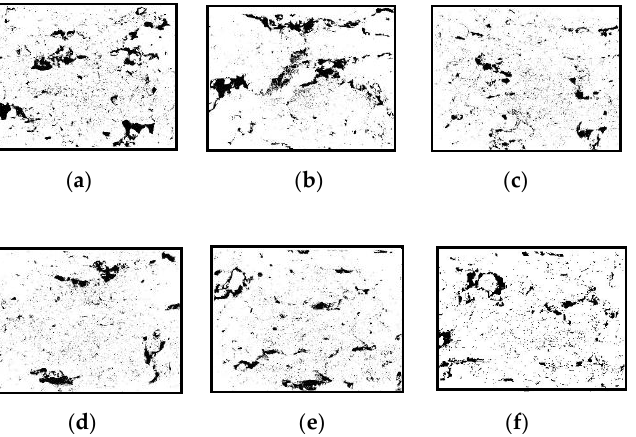
Figure 8. Image analysis images of corresponding fracture surfaces of laser-sintered 10%-CPLA parts: ( a ) the green part; ( b ) 65 °C; ( c ) 100 °C; ( d ) 110 °C; ( e ) 120 °C; ( f ) 130 °C.